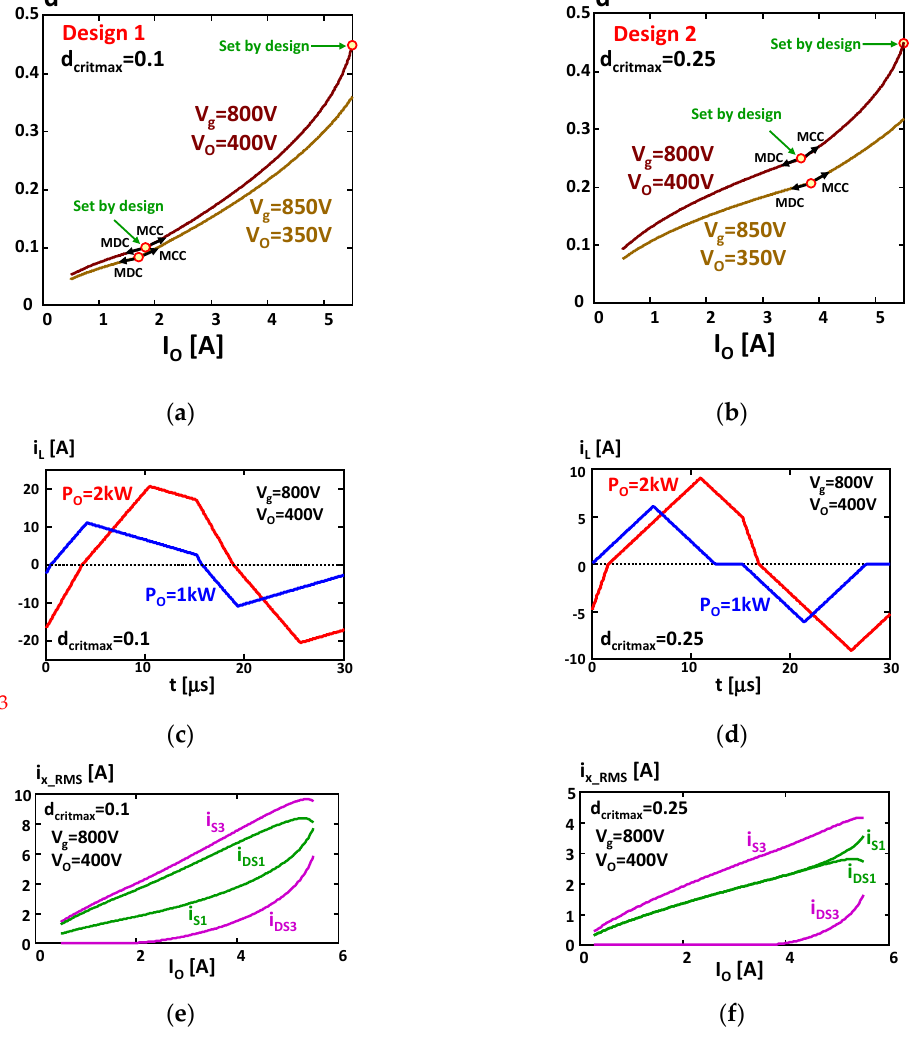
Figure 10. Analytical results using Design 1 ( d critmax = 0.1, a , c,e ) and Design 2 ( d critmax = 0.25, b,d,f ).